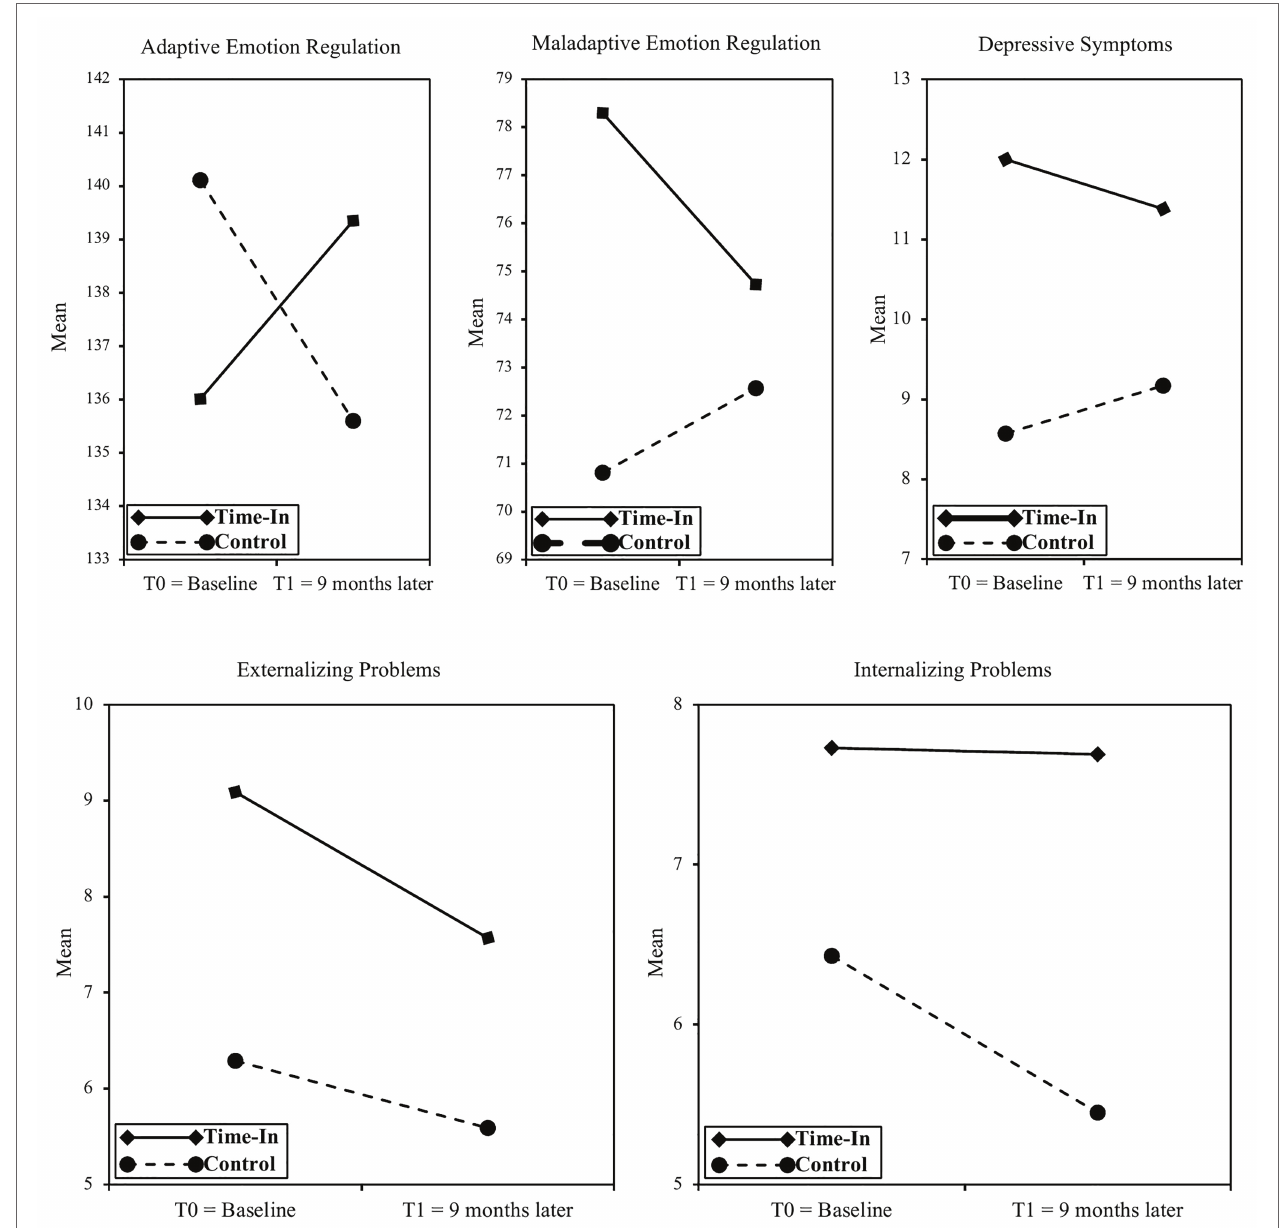
FIGURE 2 | Study variables from baseline to T1 of the intervention and control groups. Only significant Time × Condition effects were found for adaptive and maladaptive emotion